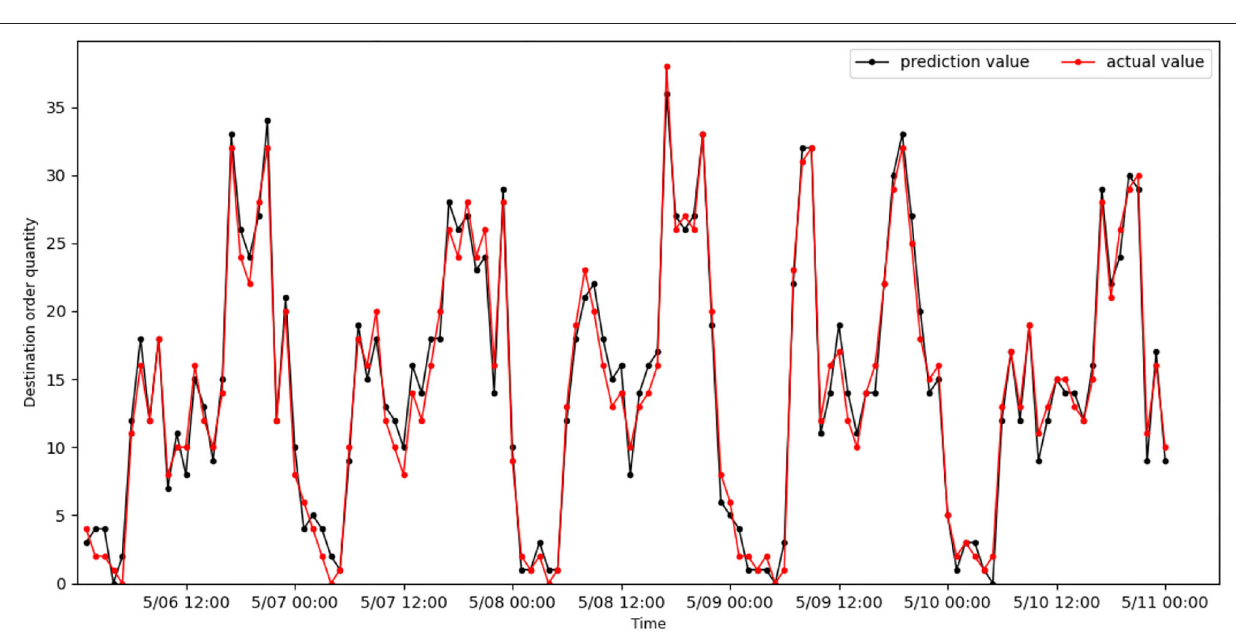
FIGURE 7 | Real online car-hailing destination orders in grid 139 are compared with predicted